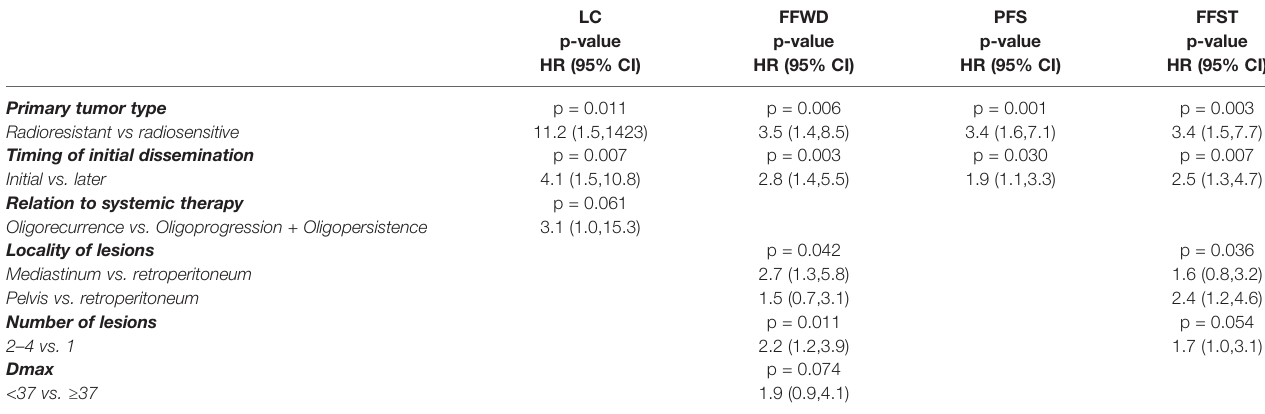
TABLE 3 | Multivariable analyses for time-to-event